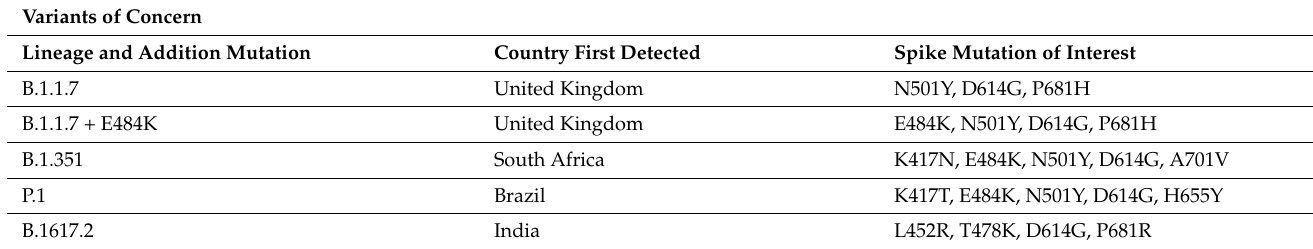
Table 2. Variants of Concern according to the latest classification by ECDC [165].